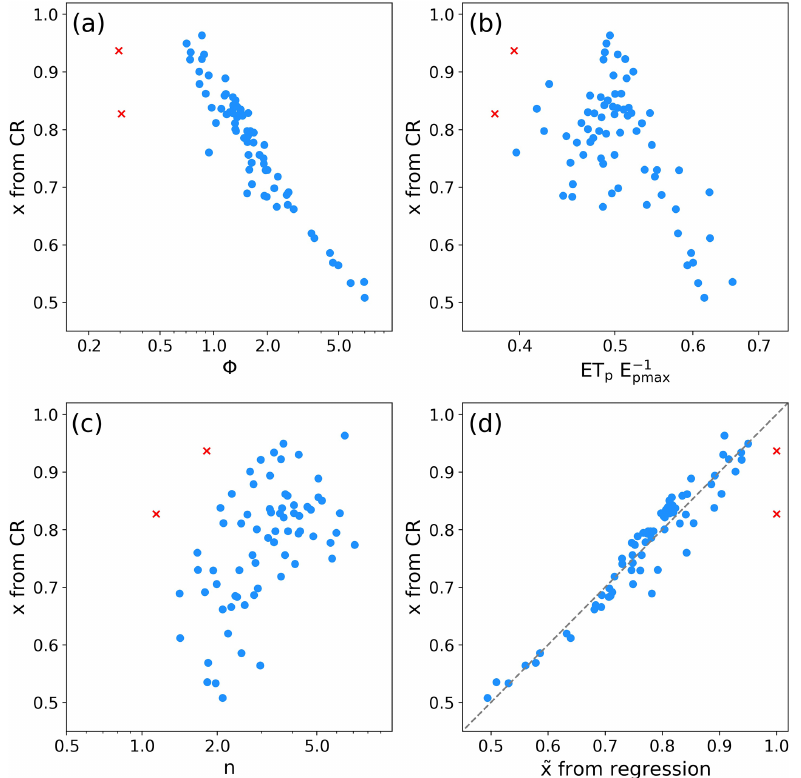
Figure 4. The scatter plots between the x estimated by CR with ET wb for 1981–1997 and the corresponding (a) (cid:56) , (b) ET p /E pmax , and (c) n values and (d) the 1 : 1 plot between the x from CR and the ˜ x predicted by Eq. (17). The red x symbols are the outliers excluded from the regression